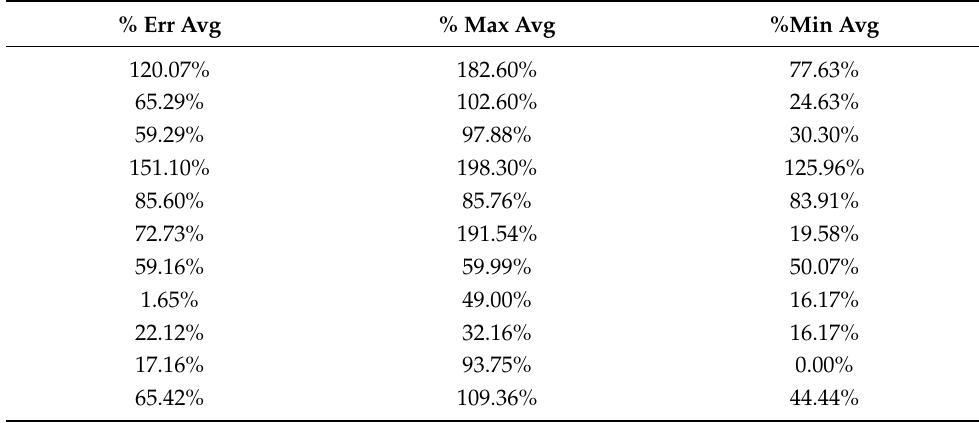
Table A120. Set 2, trials 21–30 data (all 0.5 PR values).